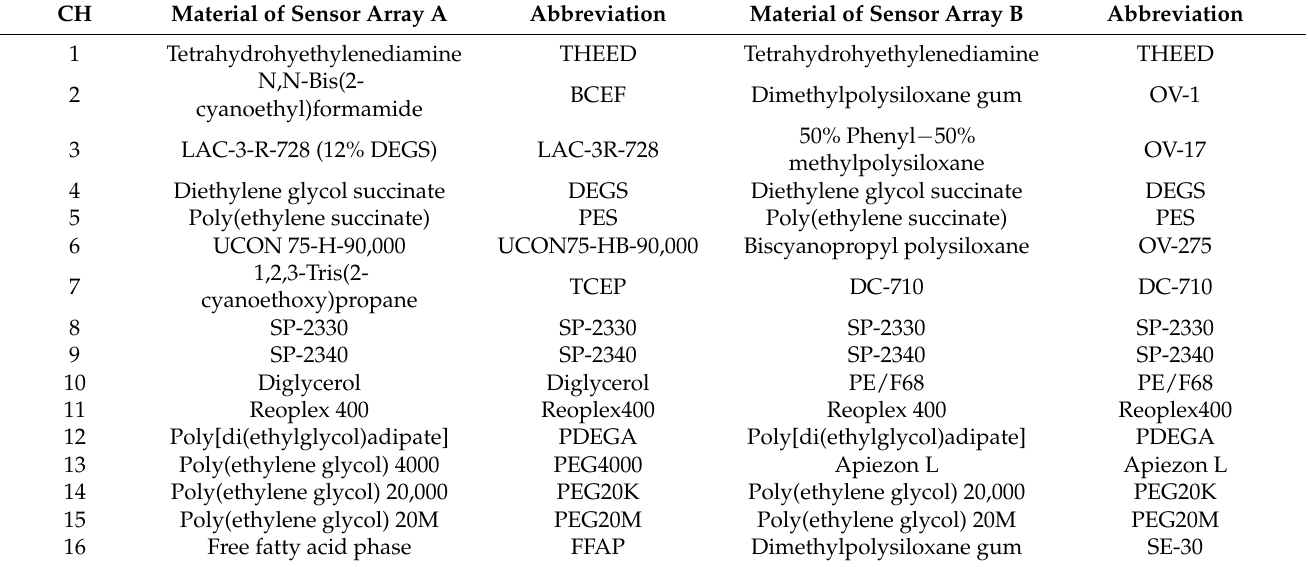
Table 2. GC materials used for each channel of the odor